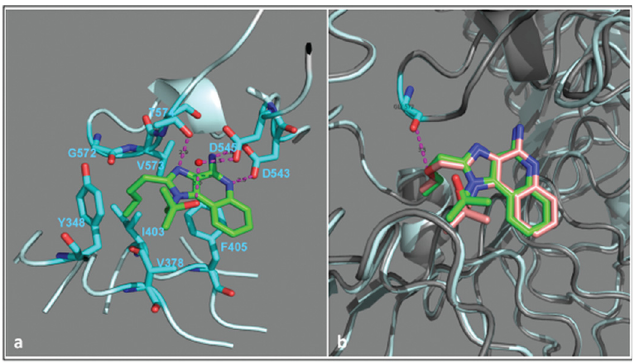
Fig 4. Crystal structure of Hybrid-2 and R848 with human TLR8. (A) The C-atoms of Hybrid-2 are shown in green, and the residues on TLR8 are shown in cyan. A water molecule involved in mediating the interaction between the hydroxyl on N 1 -substituent of Hybrid-2 and Asp545 residue is shown as a red sphere. The hydrogen bonds are represented as dashed lines in magenta, and the bond distances are marked in black. Overlay of crystal structures of Hybrid-2 and R848 with TLR8 is shown in (B). R848 is shown in light red and its TLR8 receptor shown in grey. The electrostatic repulsion between the backbone carbonyl of Gly572 residue and ether oxygen of the C2-ethoxymethyl substituent of R848 is shown in